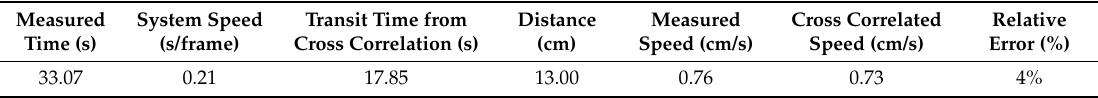
Table 3. Calculated results of the 3D